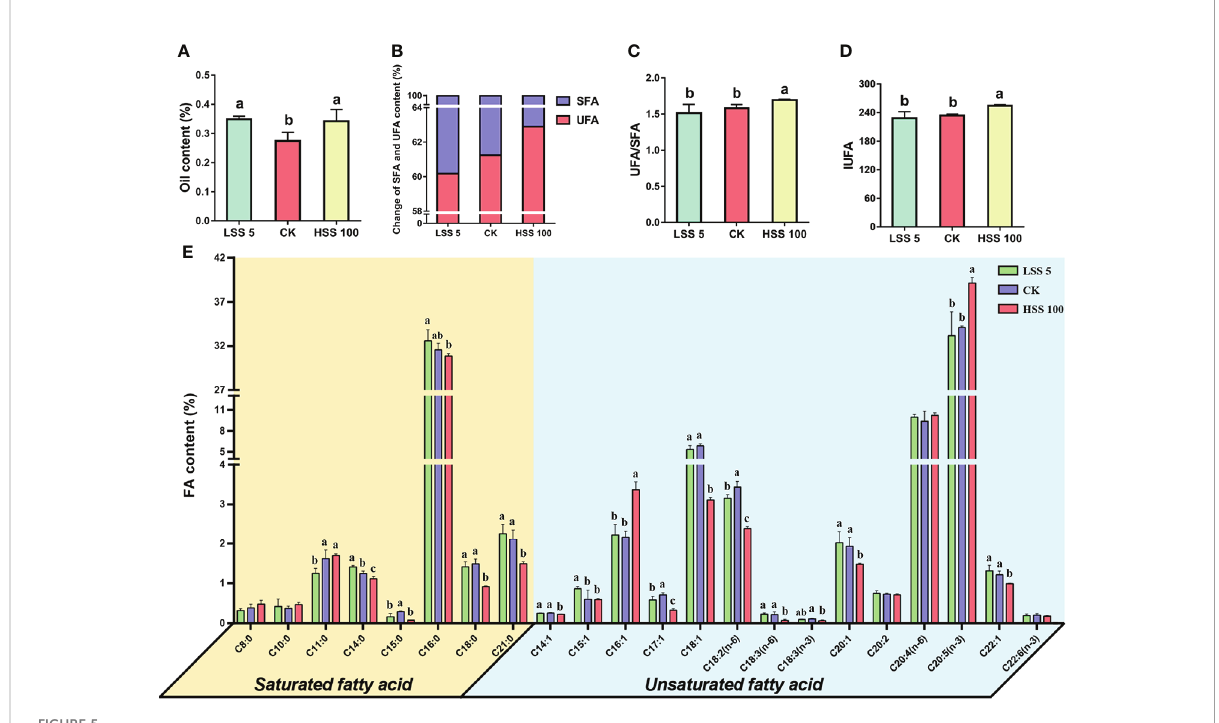
FIGURE 5 Changes in fatty acids (FAs) and related indexes of P. haitanensis after hypersaline and hyposaline treatments for 4 h. (A) Content of total FAs. (B) Changes in saturated FA (SFA) and unsaturated FA (UFA) contents. (C) Ratio of UFAs to SFAs. (D) Changes of IUFA value under salt stress; see Figure 3 for de fi nition of IUFA. (E) The content of various FAs under hypersaline and hyposaline treatments. Different letters above the bars indicate signi fi cant differences among treatments at P < 0.05, as determined by one-way ANOVA followed by Tukey ’ s test. CK, control